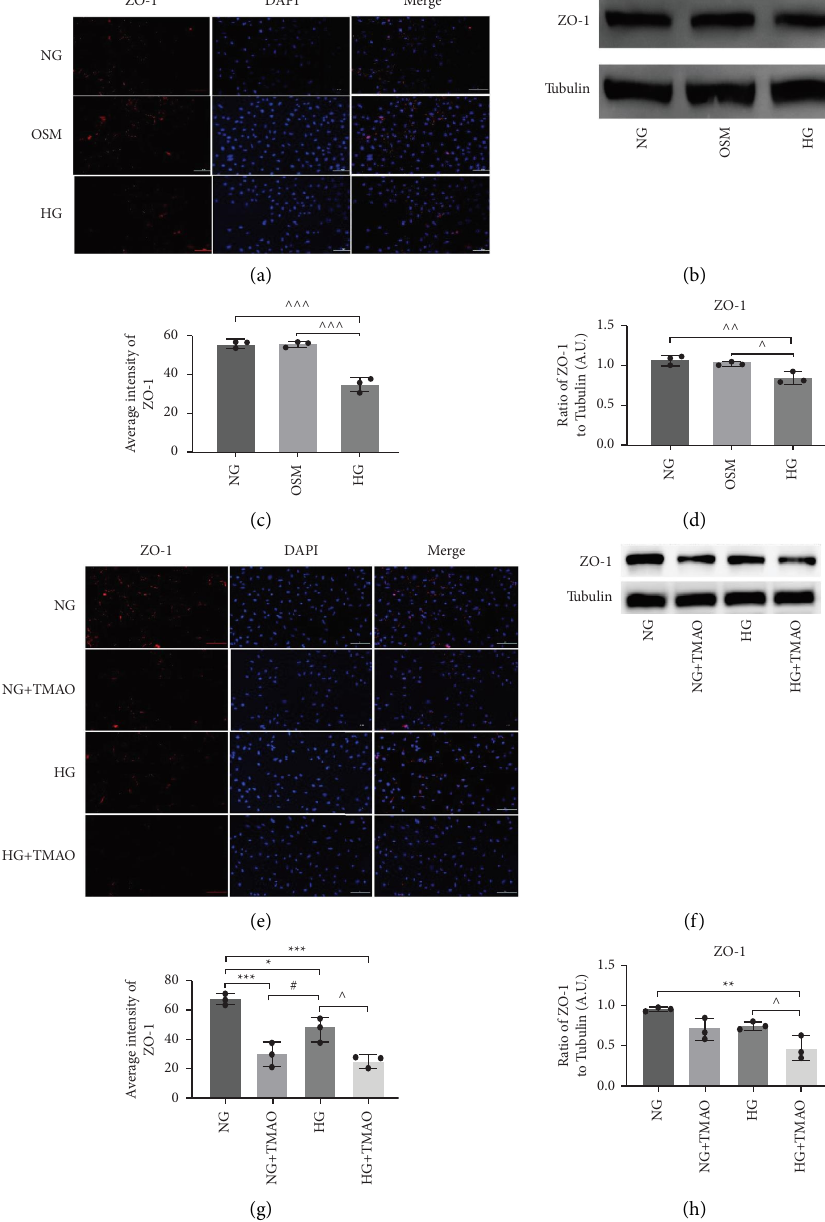
Figure 4: TMAO enhances the high-glucose-induced damage to tight junction protein ZO-1 in HRMECs. After 72 h exposure to NG (D-glucose 5.5 mM), OSM (mannitol 24.5 mM and D-glucose 5.5 mM), and HG (D-glucose 30 mM), the fuorescence and protein expression of ZO-1 were displayed (a-d). Fluorescence images showing ZO-1 expression in HRMECs after treatment with NG, NG + TMAO, HG, and HG + TMAO for 72 h (e, g). Scale, 100 μ m. Western blot analysis of ZO-1 expression (f, h). ∗ P < 0.05 vs. NG, ^ P < 0.05 vs. HG, # P < 0.05 vs. NG + TMAO, n �